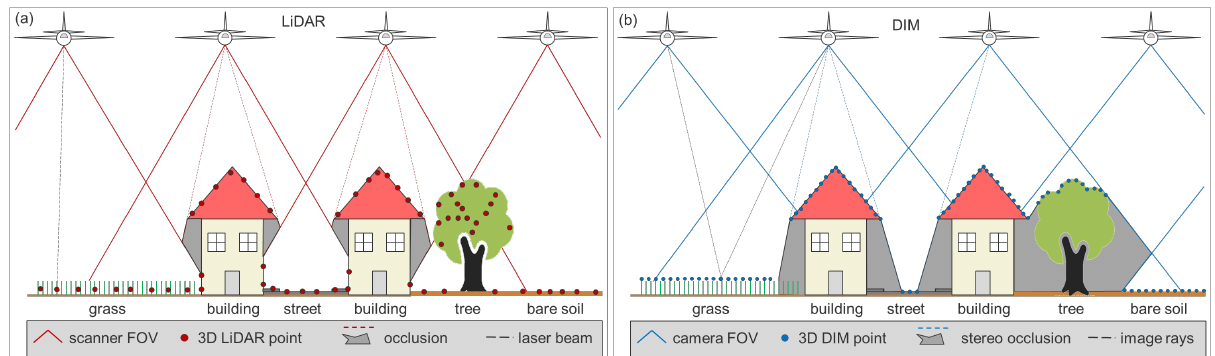
Figure 1. Schematic drawing of data acquisition based on airborne LiDAR (a) and DIM